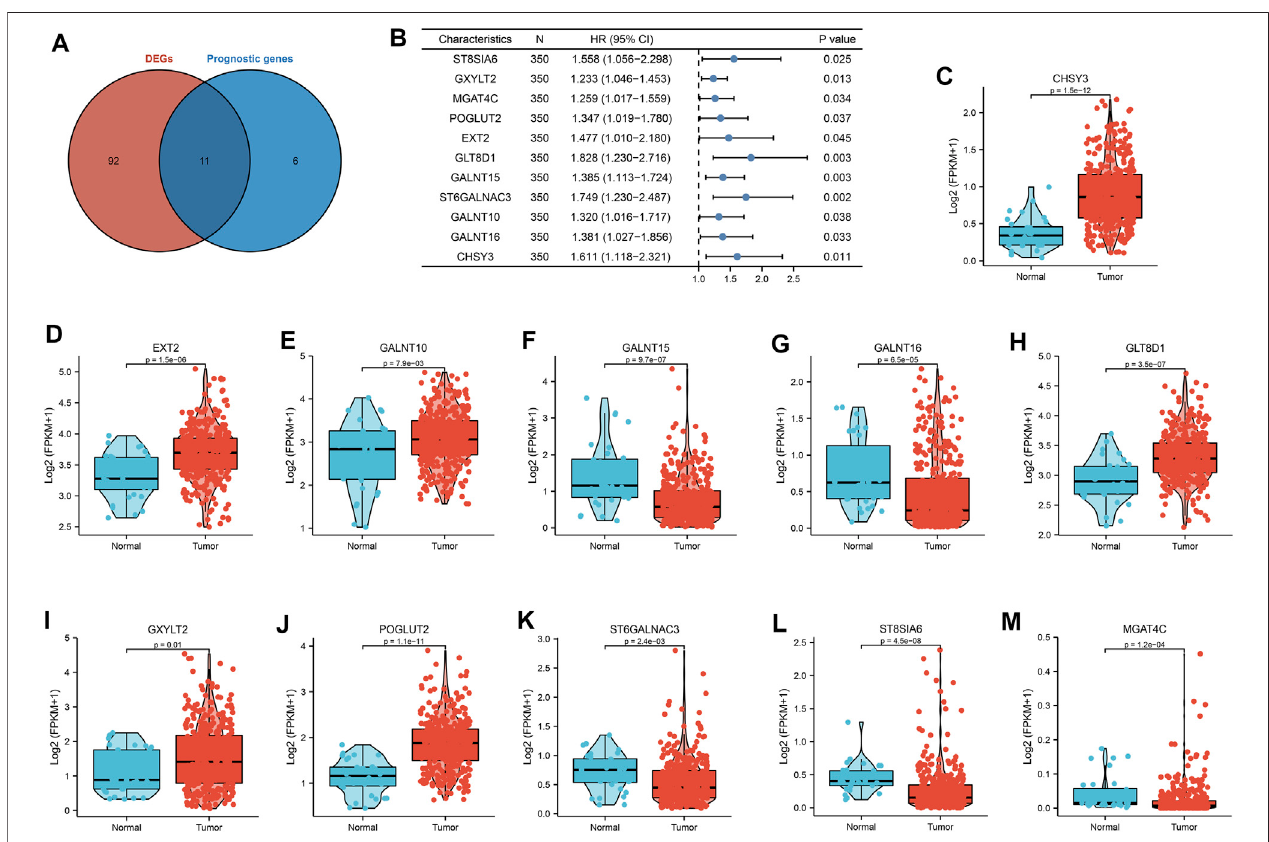
FIGURE 2 | Landscape of expression and prognosis of 11 glycosylation regulators in TCGA-STAD cohort. (A) Venn diagram to identify differentially expressed genesbetweentumor andadjacentnormaltissuethatwerecorrelatedwithoverallsurvival. (B) ForestplotsshowingtheresultsoftheunivariateCoxregressionbetween 11 glycosylation regulators and overall survival in gastric cancer. (C – M) The illustration shows the expression distribution of 11 glycosylation regulators between paired normal(blue)andgastriccancer(red)tissues.Theboxesindicatethemedian±1quartile,withthewhiskers extendingfromthehingetothesmallestorlargestvalue within 1.5× IQR from the box